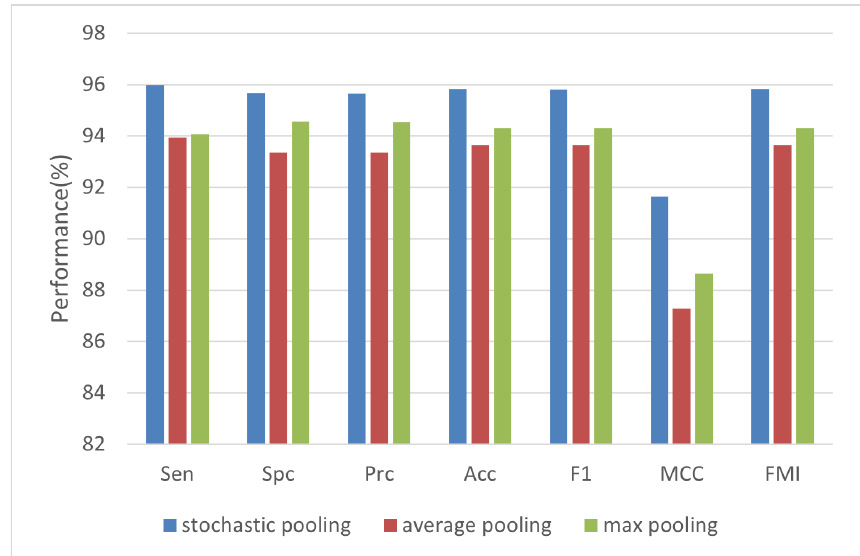
Figure 9. Pooling methods comparison.